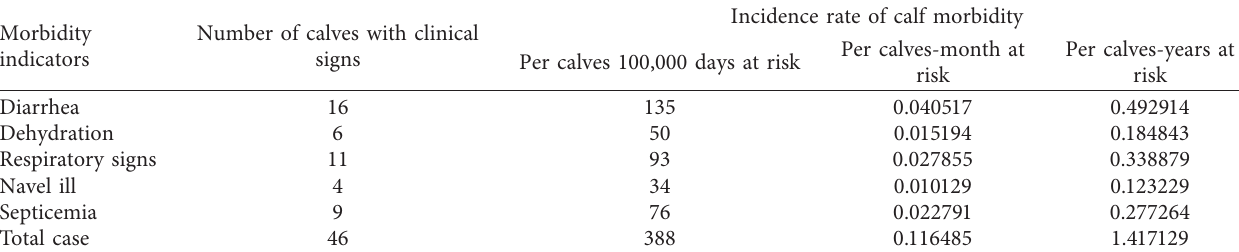
Table 5: Calves morbidity rate across the morbidity indicators ( n �